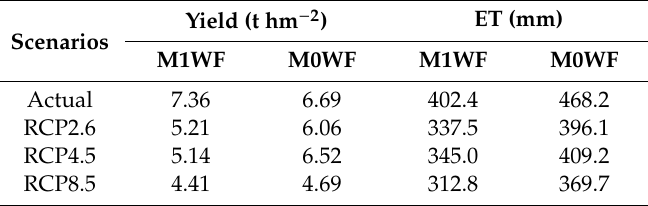
Table 10. The seed-maize yield and ET under climate change scenarios in 2050.